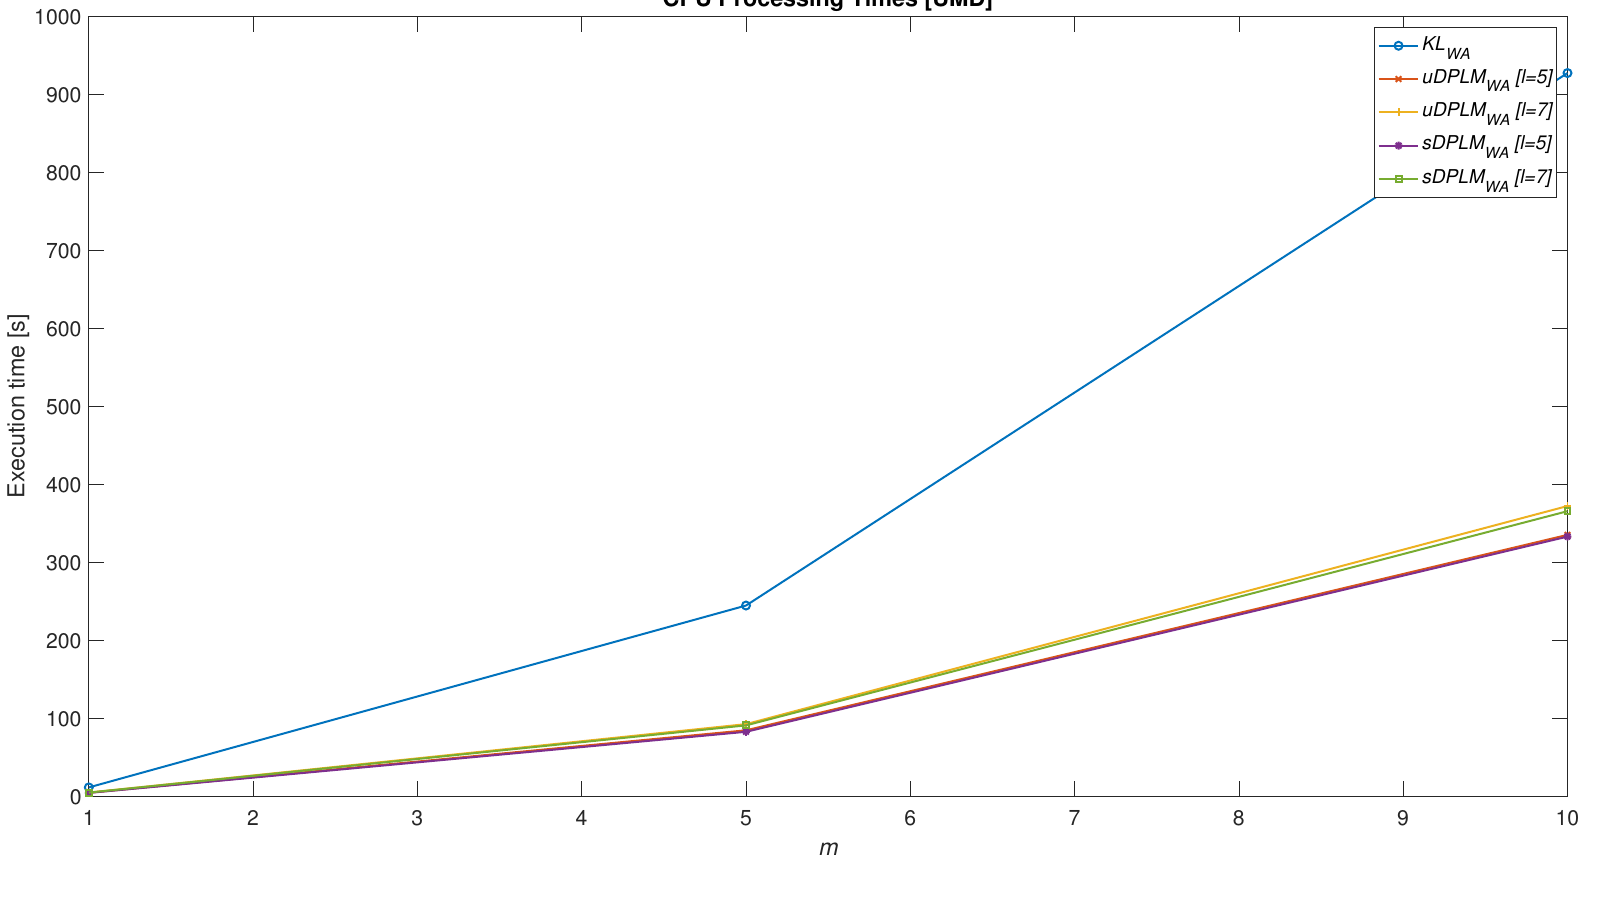
Figure 8. CPU processing times for the UMD database, DPLM WA vs. KL WA